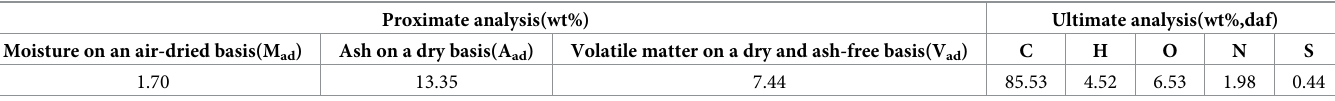
Table 1. Proximate analysis and ultimate analysis of Yangquan